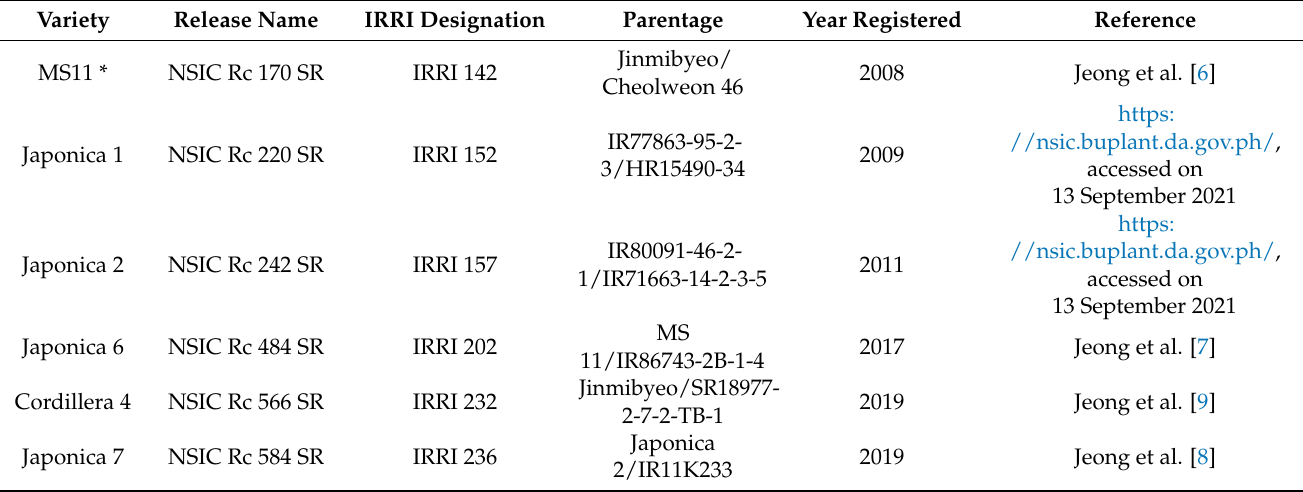
Table 1. Six temperate japonica rice varieties developed from the GUVA project.